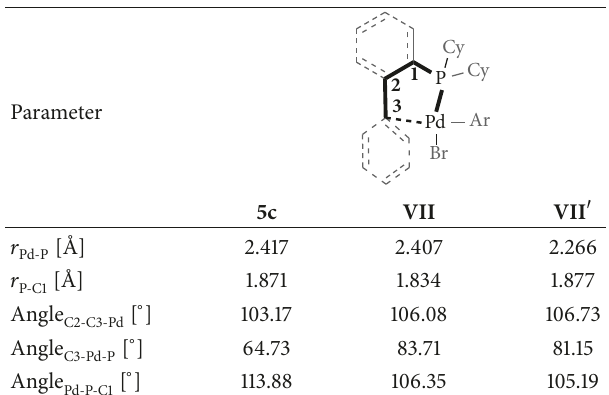
Table 1: Comparison of the key geometrical parameters of com- plexes 5c , VII , and VII 󸀠